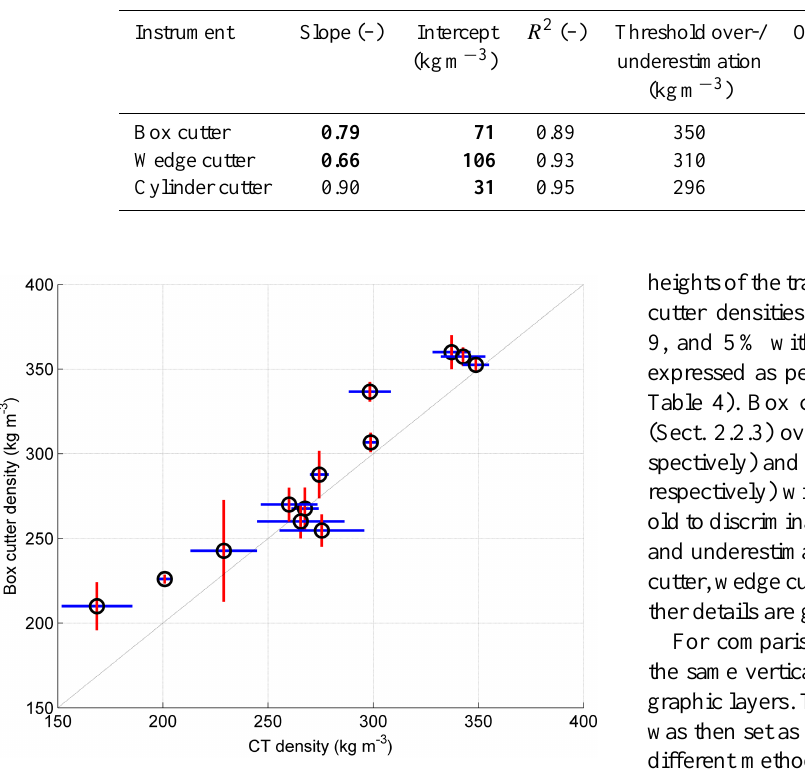
Figure 2. Comparison of density cutter and µ CT measurements in the laboratory. The top three cutter measurements (0–9cm) in each of the 13 blocks were averaged to best match the location of the µ CT samples. Error bars are ± 1 standard deviation, resulting from these three cutter measurements (red) and the three µ CT samples per block